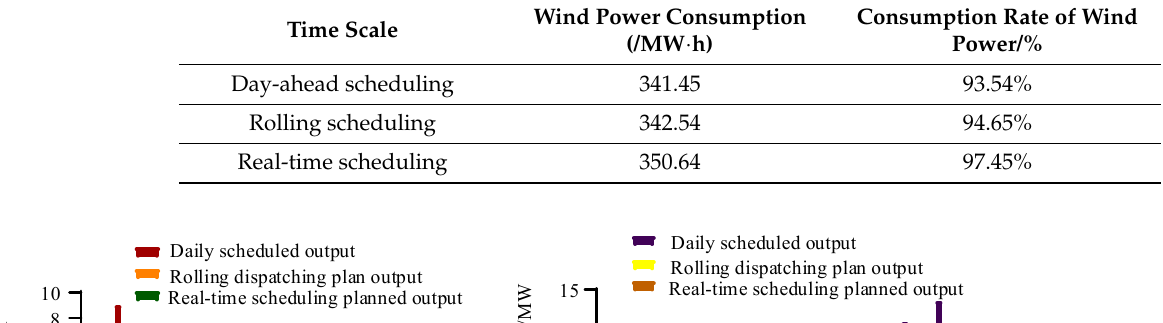
Figure A3. The results of the power data of the comprehensive energy system in di ff erent periods ( a ). Thermal power output, ( b ). Fan output pow. Table A3. The results of the electricity consumption test of the multiperiod integrated energy system.